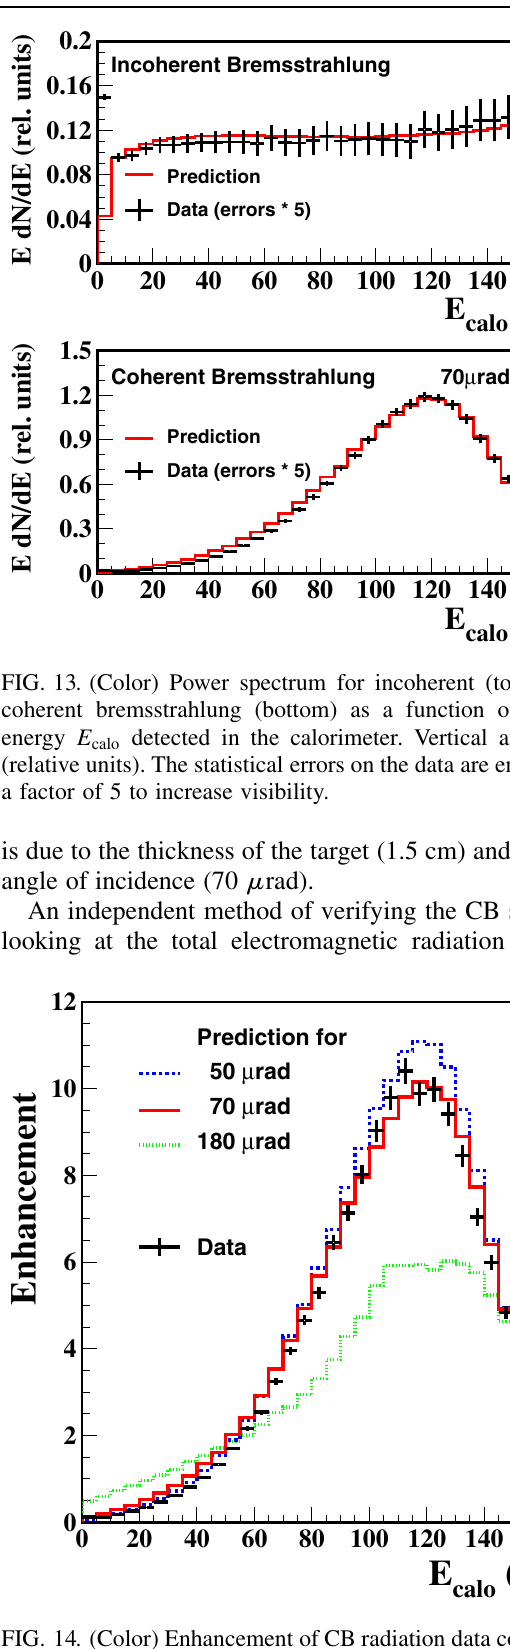
FIG. 12. (Color) Monte Carlo predictions for the single photon spectrum, compared with data using all events (stars) and only 122-type events (circles).